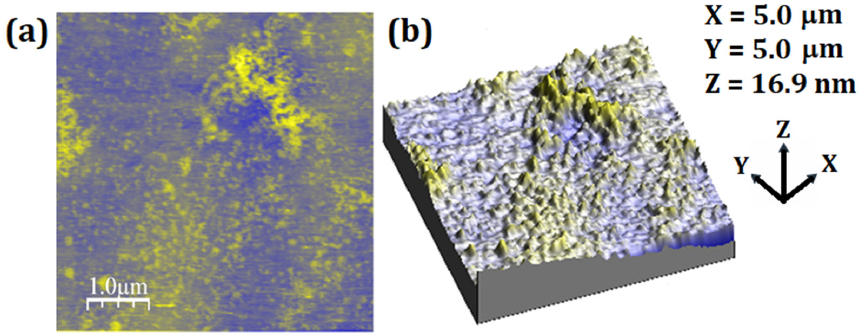
Figure 4. Two-dimensional and three-dimensional AFM micrographs: ( a ) PNE system destabilized, and ( b ) topographic map.